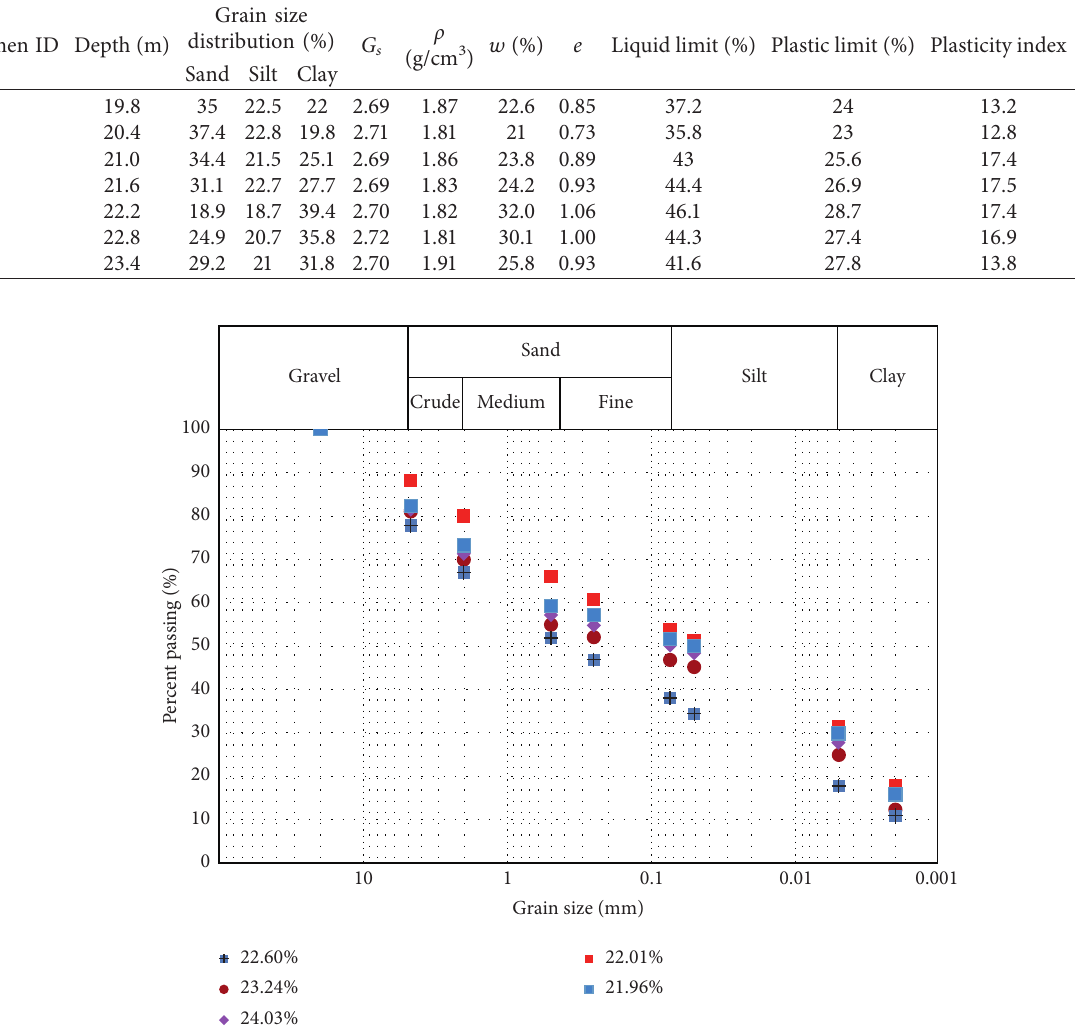
Figure 1: Grain size distribution curve of weathered CDG collected at different soil